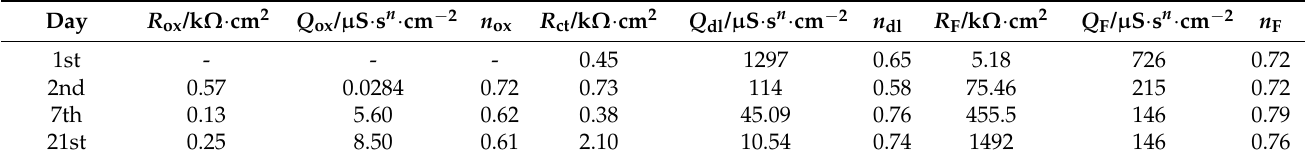
Table 7. EIS data for RG7 for continuous immersion in simulated urban rain at pH 6.5.